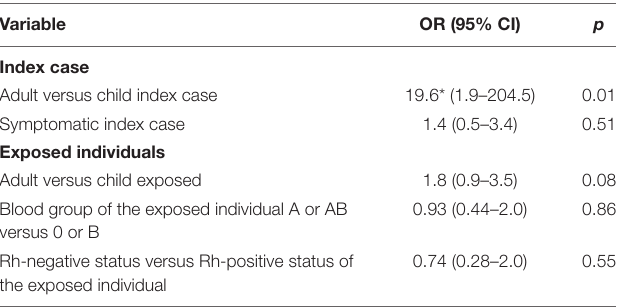
TABLE 4A | Risk factors for SARS-CoV-2 seropositivity and symptomatic infection. Generalized linear mixed model for risk of SARS-CoV-2 seropositivity of exposed household members.